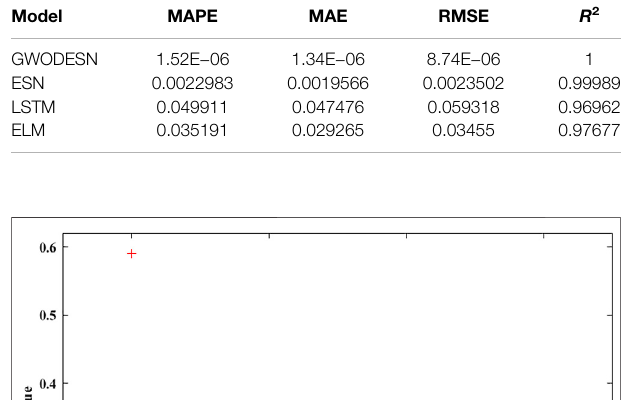
TABLE 3 | Prediction performance comparison for MG Model